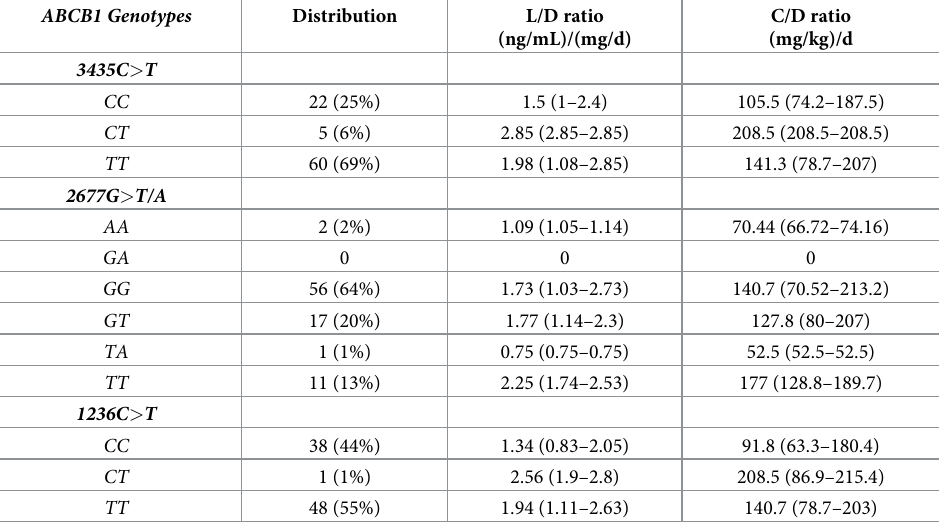
Table 4. Distribution of ABCB1 genotypes, level to dose and concentration to dose ratios after 12 months of expo- sure with tacrolimus modified release (n = 87).